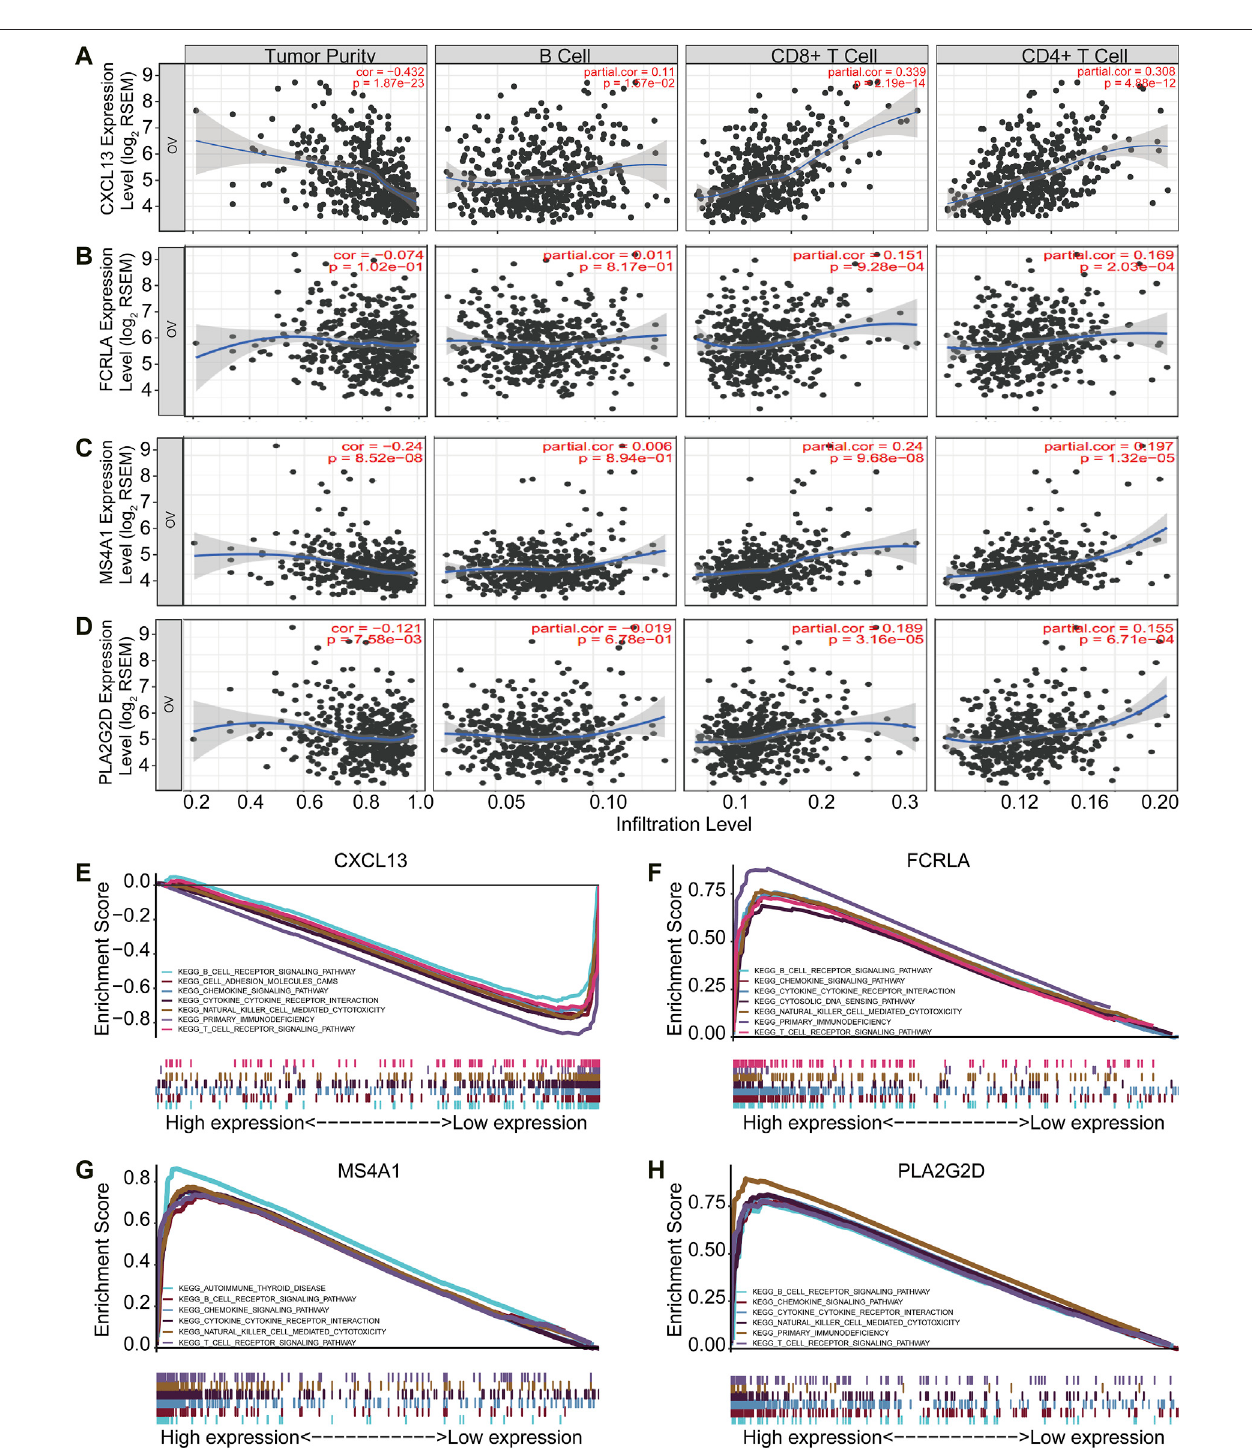
FIGURE 5 | CXCL13, FCRLA, MS4A1, and PLA2G2D correlated with immune status in OC. (A – D) The scatter plot shows the correlation between the expression of CXCL13, FCRLA, MS4A1, PLA2G2D, and the immune in fi ltration in OC samples from the TIMER website. (E – H) GSEA analyzed the correlation between the expression levels of four genes and the KEGG pathway. Genes expressed in the pro fi le datasets were ranked by fold changes (high-expression/low-expression). GSEA correlationpathwaysweredeterminedbythegivenalgorithm.Theverticalbarsonthe x -axisoftheGSEAdiagramrepresentthepositionsofgenesinagivensetina sorted list. Positive and negative GSEA curves mean positive and negative enrichments,